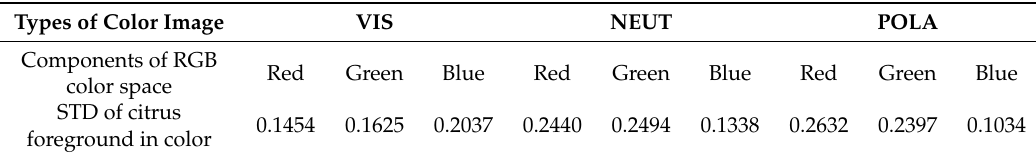
Table 1. STD of RGB components for types of color images.